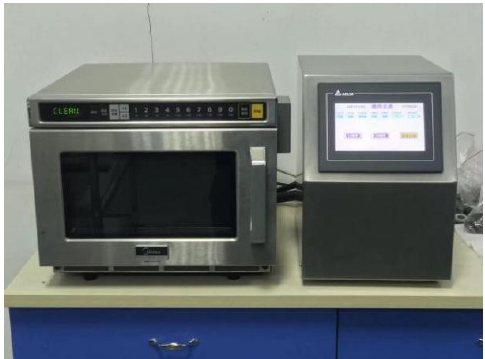
Figure 1. The modi fi ed EMB17G4V-SS commercial microwave oven. Figure 1. The modified EMB17G4V-SS commercial microwave oven.